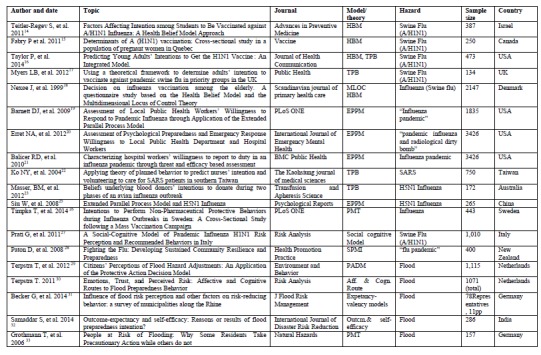

Appendix 2. Table 1